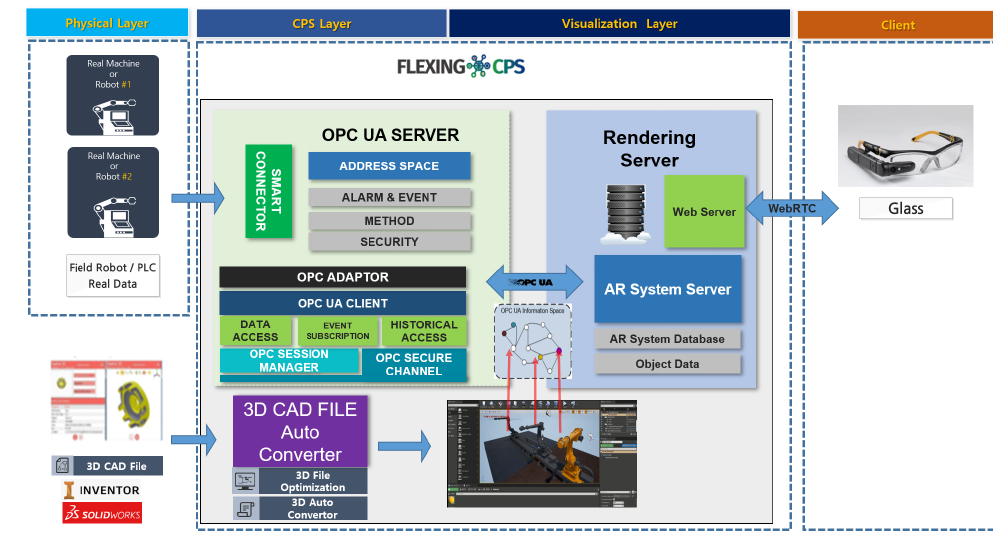
Figure 4. System architecture of VR